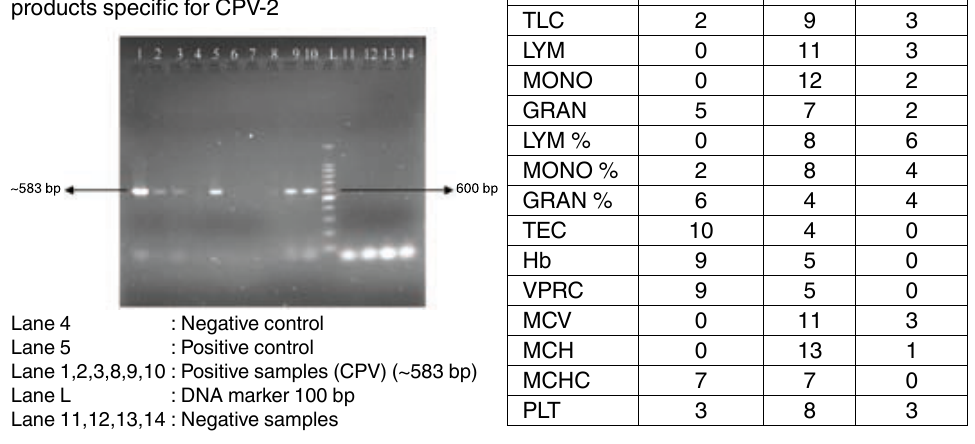
Fig. 1. Agarose gel electrophoresis of PCR products specific for CPV-2